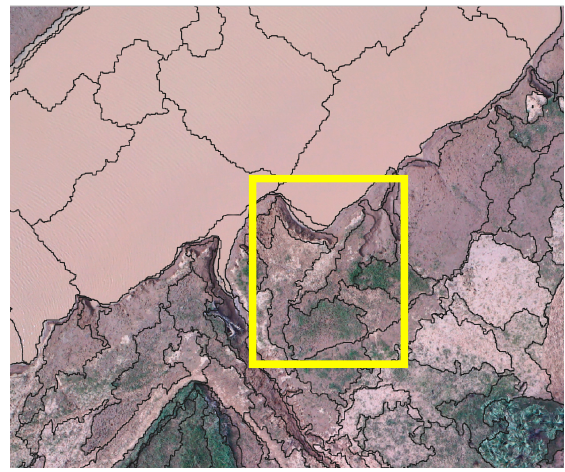
Figure 10. Detail of the segmentation process. The yellow square indicates two objects of mixed class: grassland and wet areas.